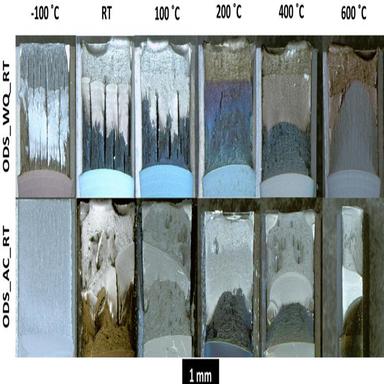
Stereo microscope macroscopic images of fracture surfaces of ODS_WQ_RT and ODS_AC_RT at different temperatures